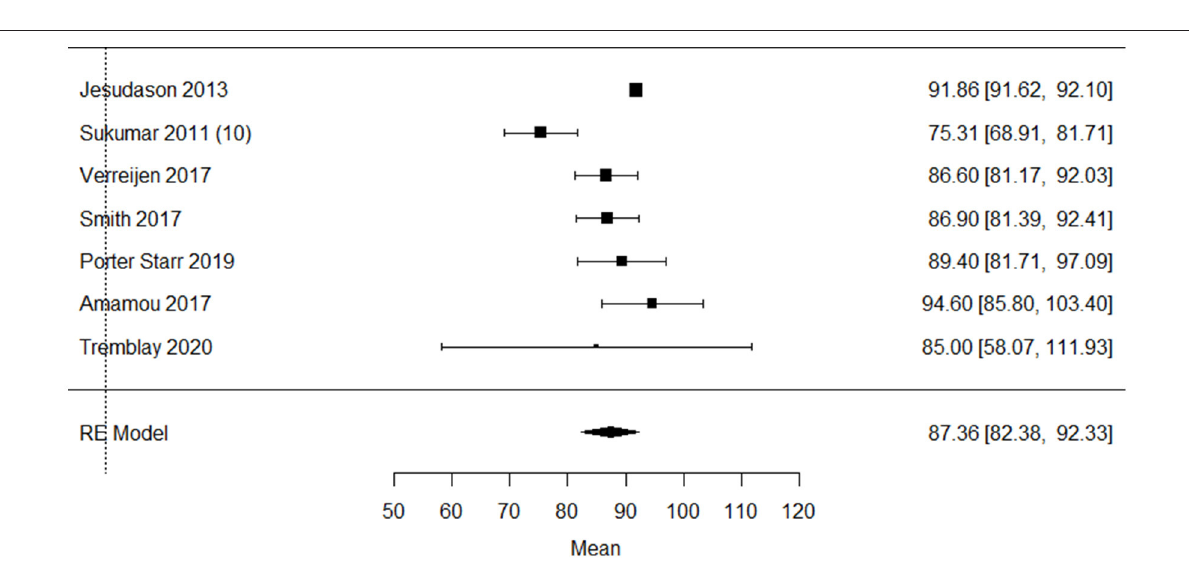
FIGURE 3 | Forest plot of included studies on protein intake (g/day) in older adults with overweight/obesity mean [95% confidence interval], RE, random